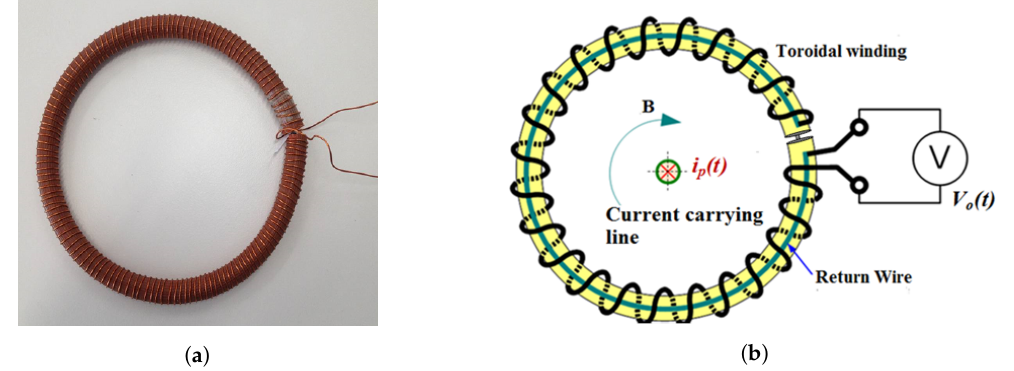
Figure 3. ( a ) Physical image ( b ) Construction of Rogowski coil.